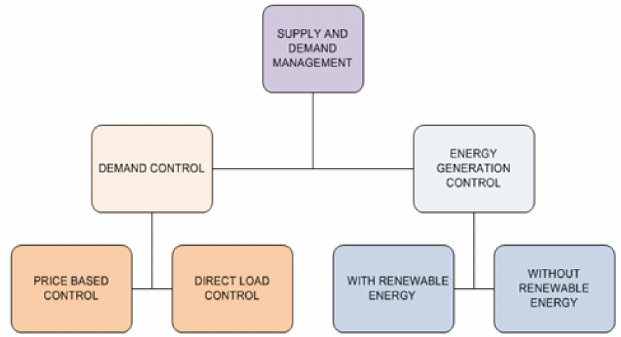
Figure 12. Supply and demand management classification.